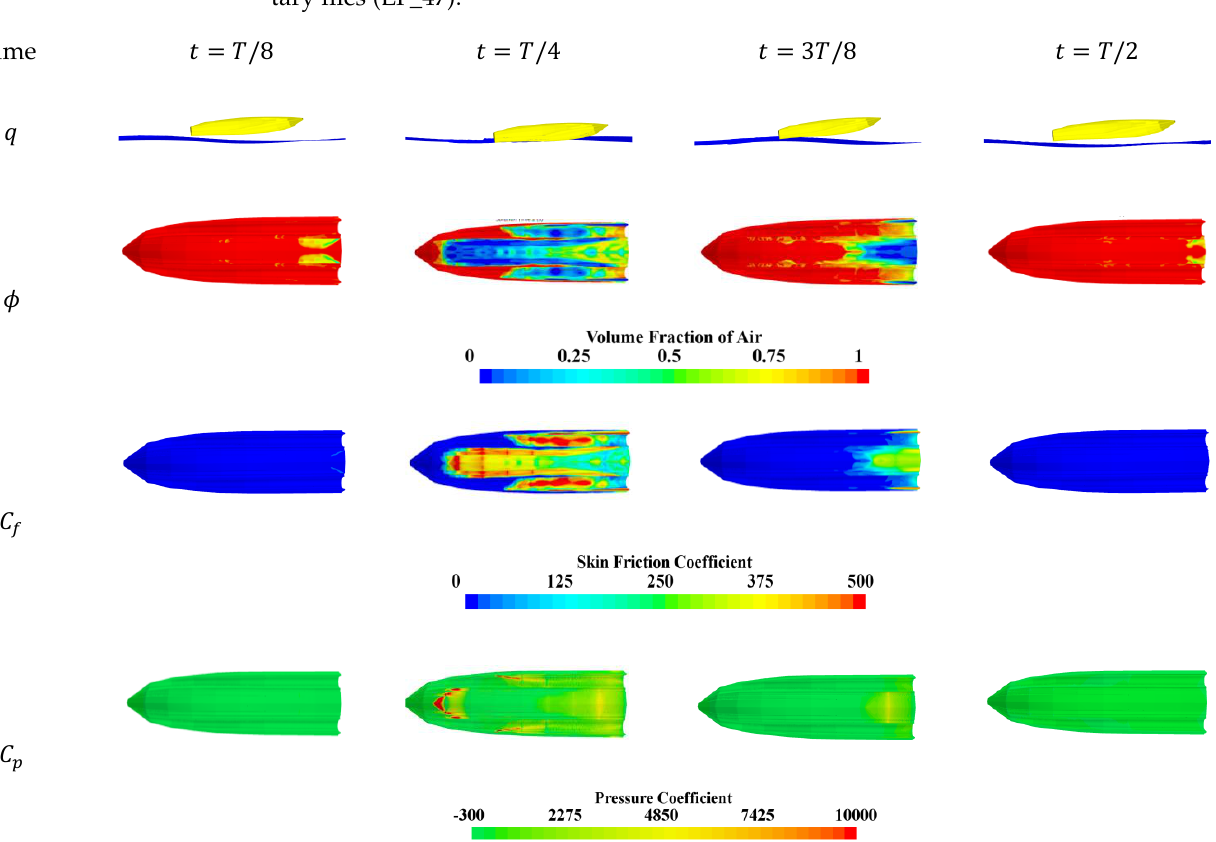
Figure 15. As in Figure 13, but for a beam Froude number of 4.7.